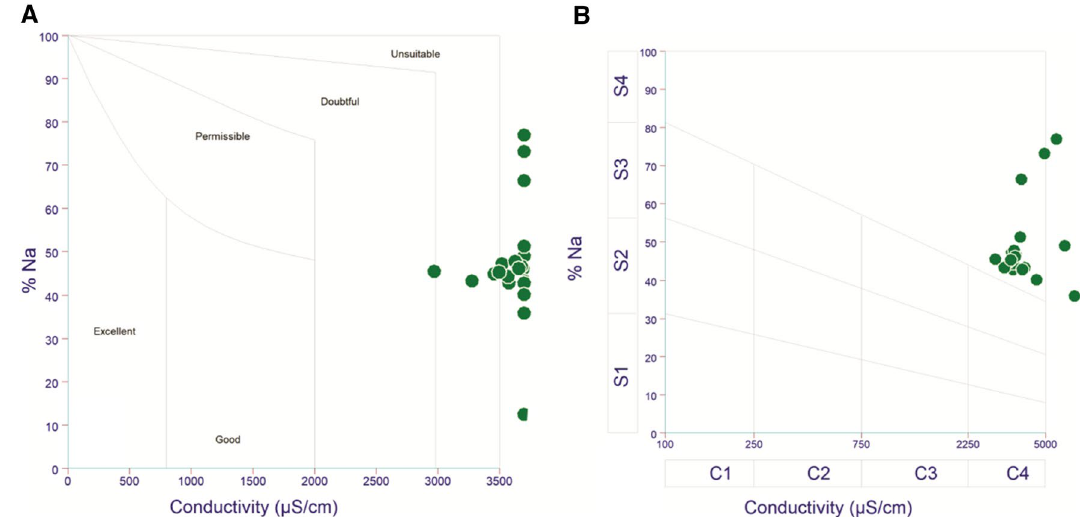
Fig. 3 Distribution of Na percent: a Wilcox diagram; b Riverside diagram